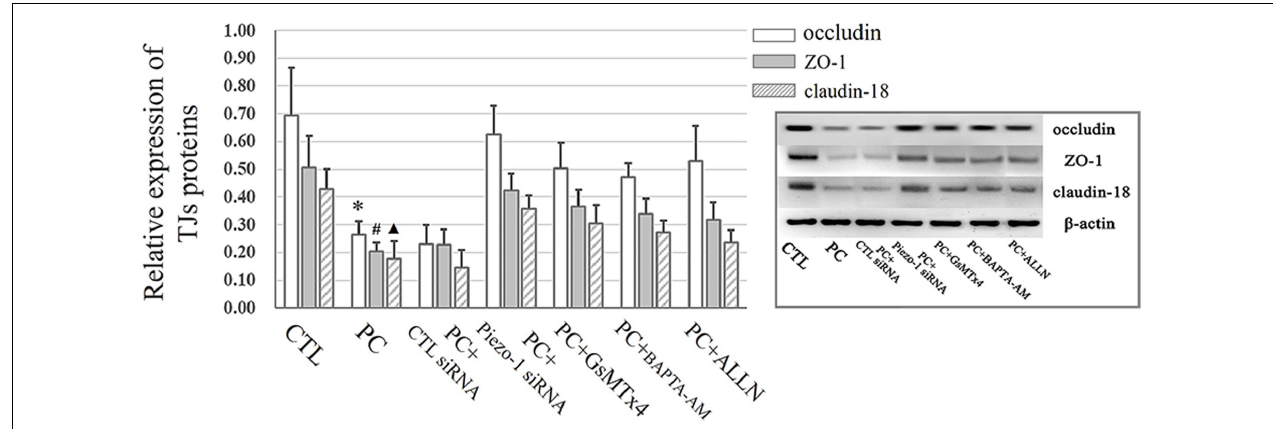
FIGURE 6 | Western blot assay to detect TJ proteins. Cells propagated under normal atmospheric pressure were set as the control (CTL). HSAECs exposed to 10 cmH 2 O of pressure for 12 h were marked as the ‘pressure culture’ (PC) group. Data are represented as the mean ± SD, n = 6. Differences between groups were analysed using one-way ANOVA, followed by Bonferroni’s test. ∗ P < 0.05 vs. the occludin level in ‘PC + piezo-1 siRNA,’ ‘PC + GsMTx4,’ ‘PC + BAPTA-AM,’ or ‘PC + ALLN.’ # P < 0.05 vs. the ZO-1 level in ‘PC + piezo-1 siRNA,’ ‘PC + GsMTx4,’ ‘PC + BAPTA-AM,’ or ‘PC + ALLN.’ (cid:78) P < 0.05 vs. the claudin-18 level in ‘PC + piezo-1 siRNA,’ ‘PC + GsMTx4,’ ‘PC + BAPTA-AM,’ or ‘PC + ALLN.’